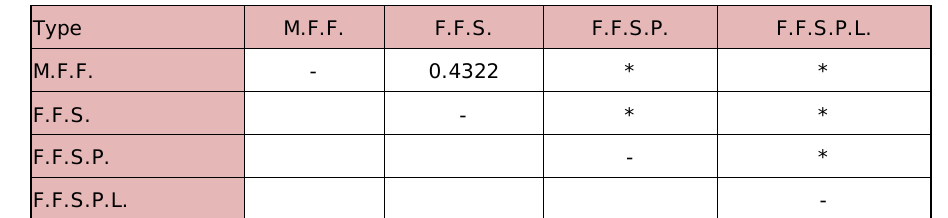
Table 7. “Fisher’s LSD on Area